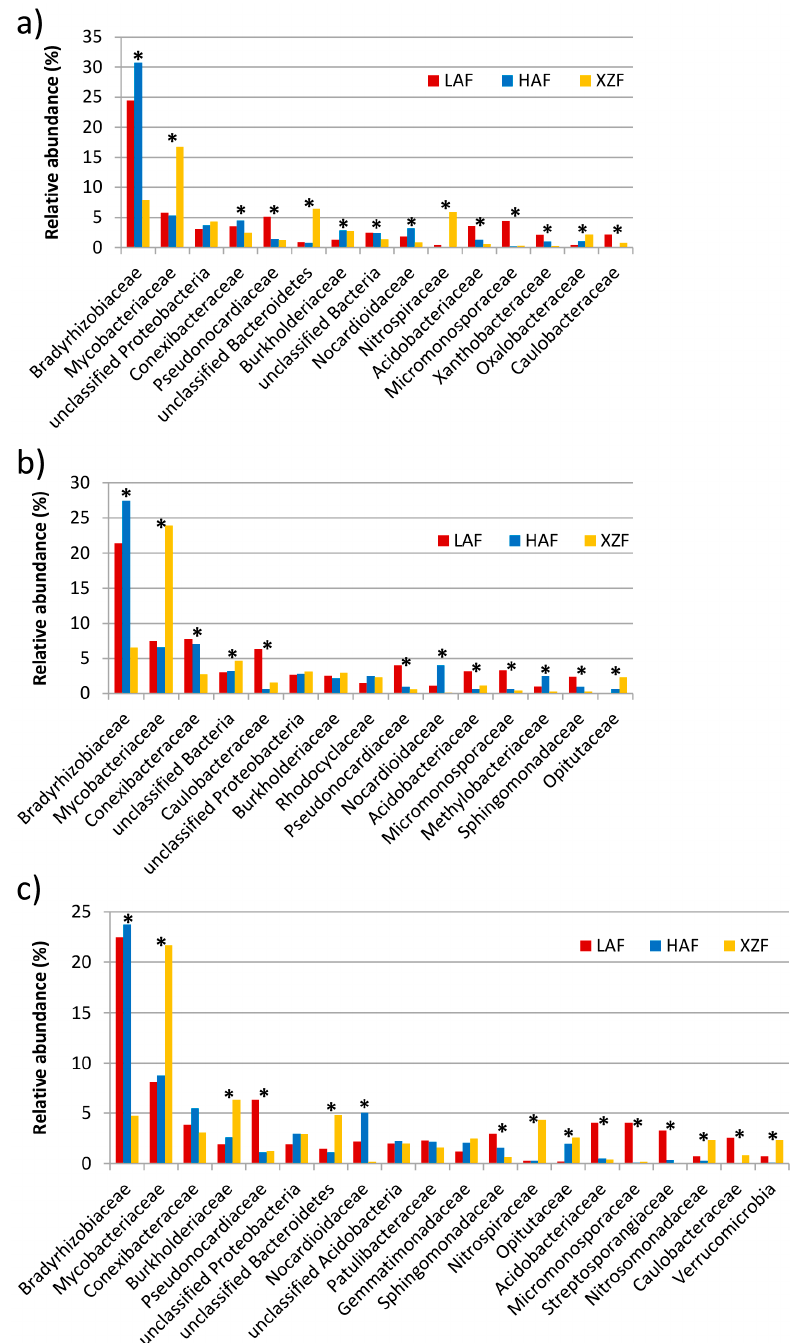
Figure 6. Phylogenetic classification at the family level for methane metabolism ( a ), sulfur metabolism ( b ) and nitrogen metabolism ( c ) sequences, performed by BLASTX analysis against the Greengenes genome database using the IMG/JGI web server. The Y axis represents the relative abundance of each taxon expressed as a percentage. Those families with more than 2% abundance in at least one of the datasets are shown. Functional groups with statistical significant differences between samples are marked with asterisk.